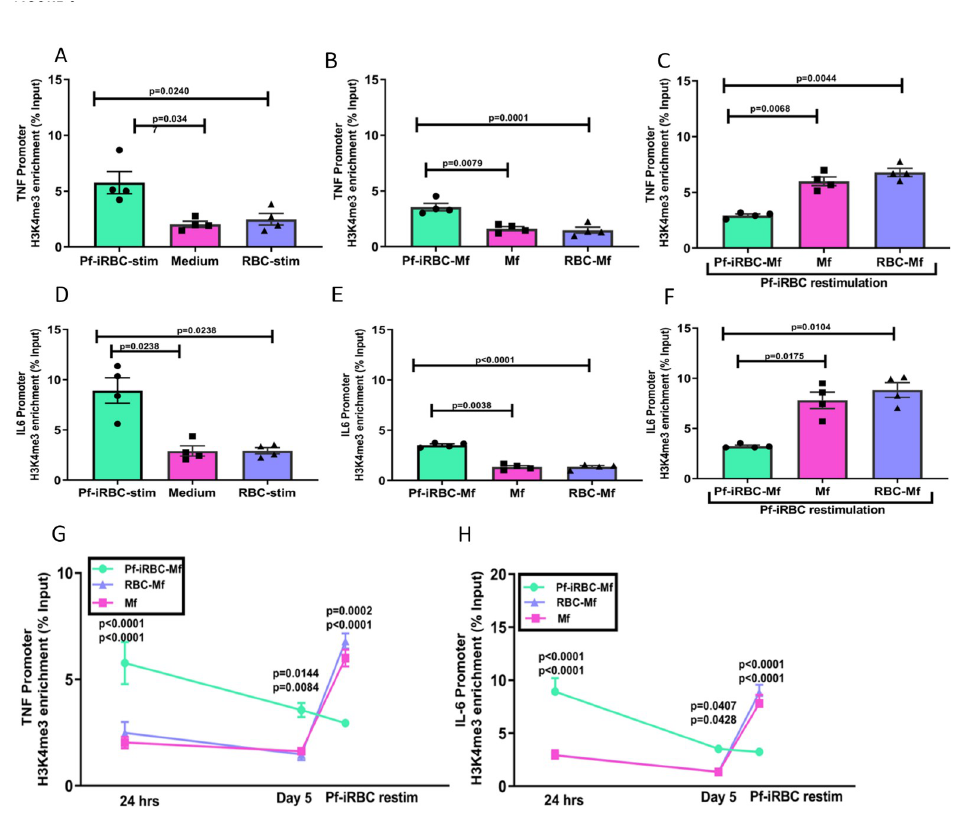
Fig 6. P . falciparum exposure drives epigenetic reprogramming of monocyte/macrophages toward a regulatory phenotype. Monocytes of U.S. adults (n = 4) were incubated with medium, RBC or Pf -iRBC for 24 hours and then analyzed by chromatin immunoprecipitation (ChIP) and RT-PCR to quantify H3K4me3 enrichment at ( A ) TNF and ( D ) IL-6 promoter sites. Replicate monocytes were incubated with medium, RBC or Pf -iRBC, washed at 24 hours, and incubated for 3 days in human serum to permit Mf differentiation. On day 5, cells were analyzed by ChIP and RT-PCR to quantify H3K4me3 enrichment at ( B ) TNF and ( E ) IL-6 promoter sites. Finally, replicate monocytes were incubated with medium, RBC or Pf -iRBC, washed at 24 hours, incubated for 3 days in human serum, co-cultured with Pf -iRBC for 24 hours, and analyzed by ChIP and RT-PCR to quantify H3K4me3 enrichment at ( C ) TNF and ( F ) IL-6 promoter sites. Kinetics of H3K4me3 enrichment at ( G ) TNF and ( H ) IL-6 promoter sites across indicated timepoints. Results are shown as means ± SEM fold enrichment of H3K4me3 antibody as percent of input. (A-F) One-way ANOVA with Tukey’s adjustment for multiple comparisons. P values indicate level of significance. (G, H) Two-way ANOVA with Tukey’s adjustment for multiple comparisons. P values indicate level of significance between Pf-iRBC vs. medium and Pf-iRBC vs. RBC,